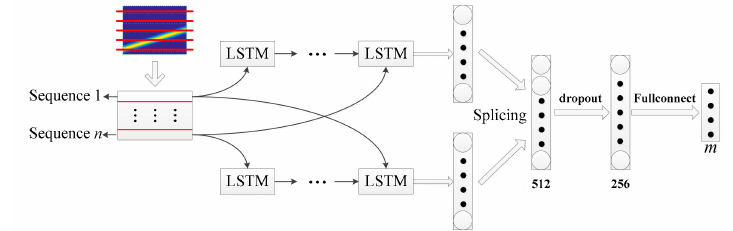
Figure 13. Internal structure of